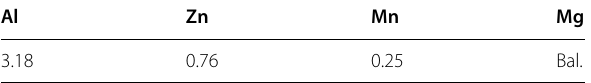
Table 1 Chemical composition of the AZ31B alloy (wt%)